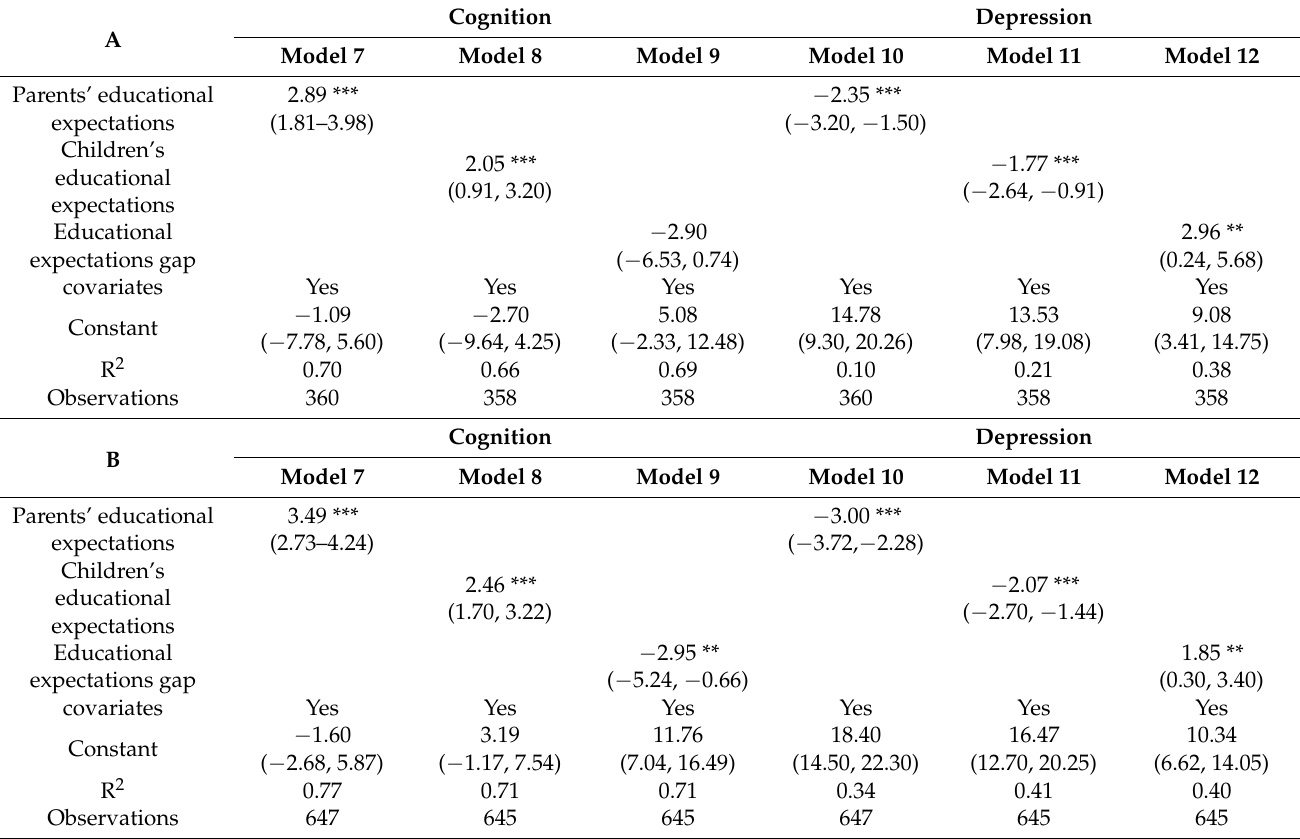
Table 3. ( A ) Benchmark regression results (Urban). ( B ) Benchmark regression results